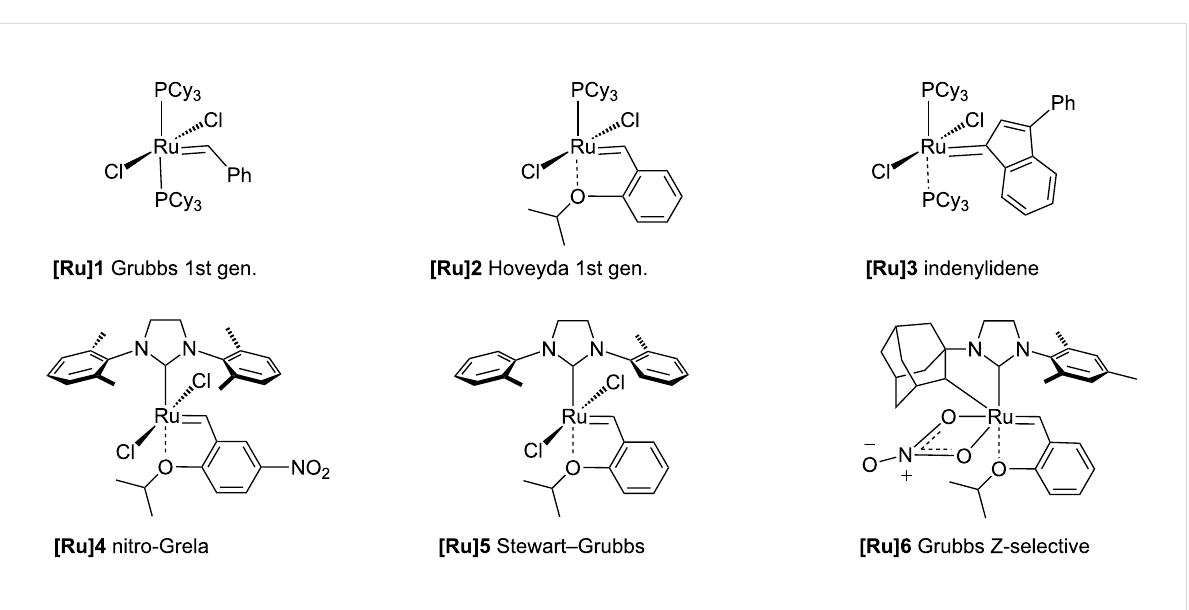
Figure 1: Chemical structures of catalysts [Ru]1–6 used in this